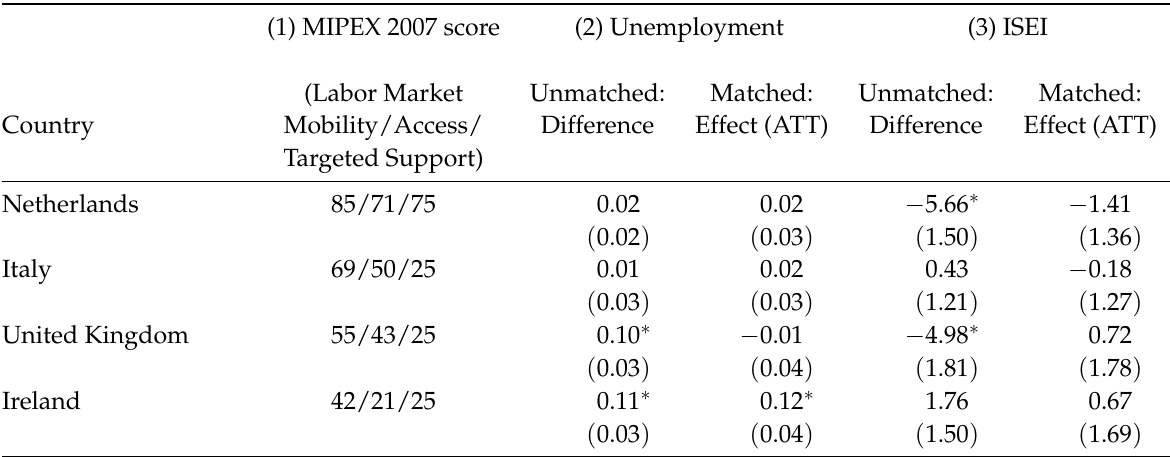
Table 4: Difference between Control and Treatment Groups in the Outcomes of Labor Market Counseling before and after